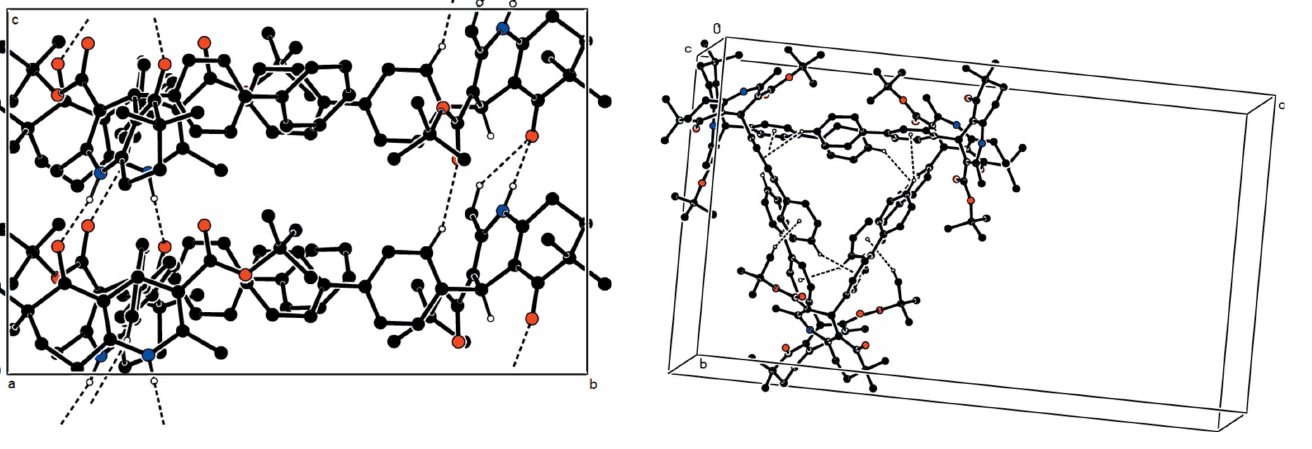
Figure 4 A general view of a part of the molecular packing formed by C—H (cid:2)(cid:2)(cid:2) (cid:2) interactions in the crystal structure of the title compound. Only the major component of the disordered molecule C is